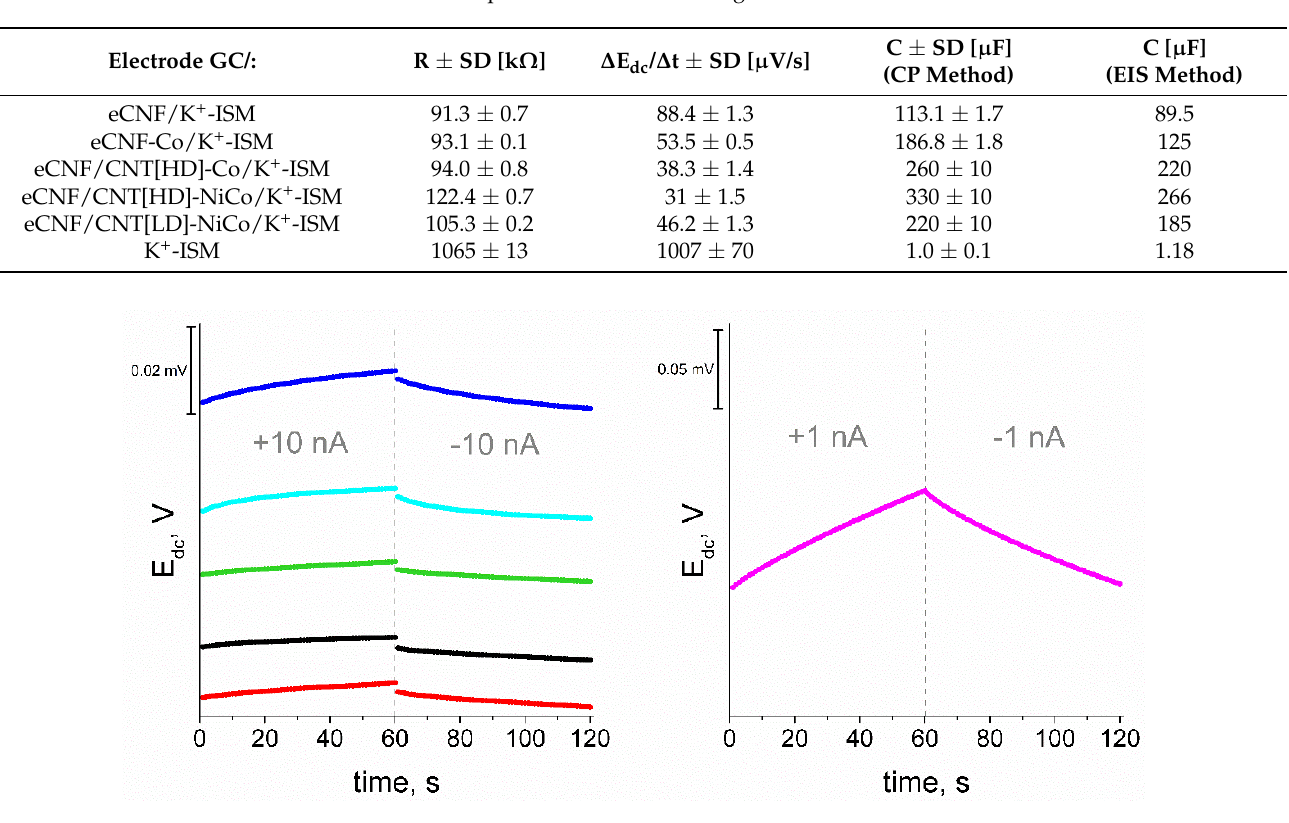
Figure 9. Chronopotentiograms of a GC/eCNF/K + ‐ ISM (blue), GC/eCNF ‐ Co/K + ‐ ISM (cyan), GC/eCNF/CNT[HD] ‐ Co/K + ‐ ISM